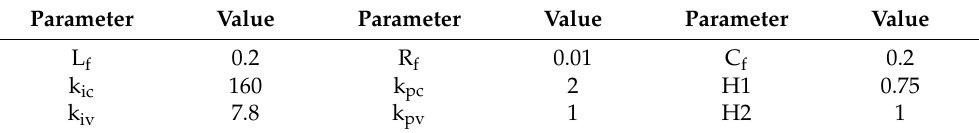
Table 1. Grid-forming VSC parameters (in p.u).